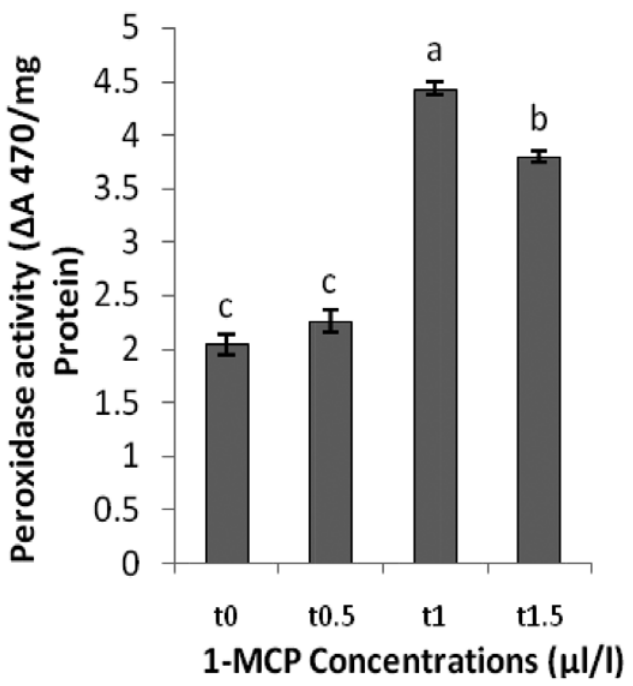
Fig. 6 - Effect of 1-MCP on petal peroxidase enzyme of carnation cv. Fortune.